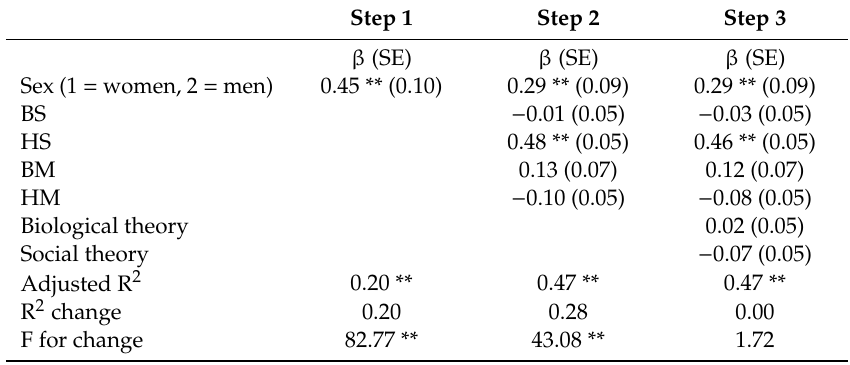
Table 4. Hierarchical regression analysis predicting moral disengagement in sexual